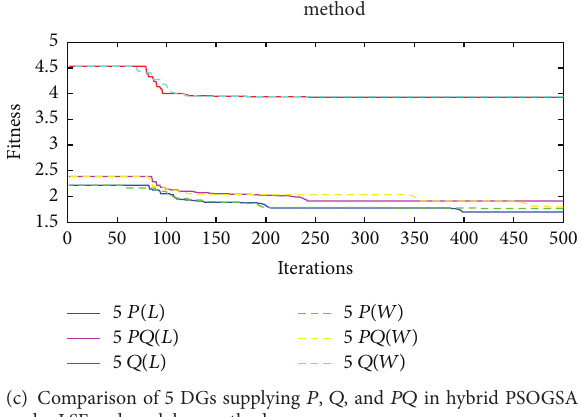
Figure 5: Fitness values of 𝑃 alone, 𝑄 alone, and both 𝑃 and 𝑄 cases under LSF and WK bus